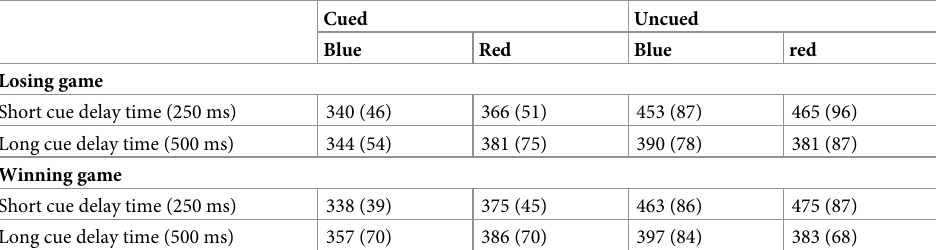
Table 3. Mean reaction times and standard deviations of the spatial orientation task in the cross-sectional sample (n =